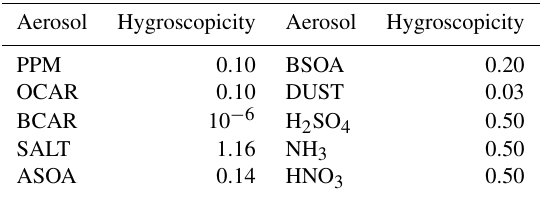
Table 4. Hygroscopic properties of the aerosols modeled in